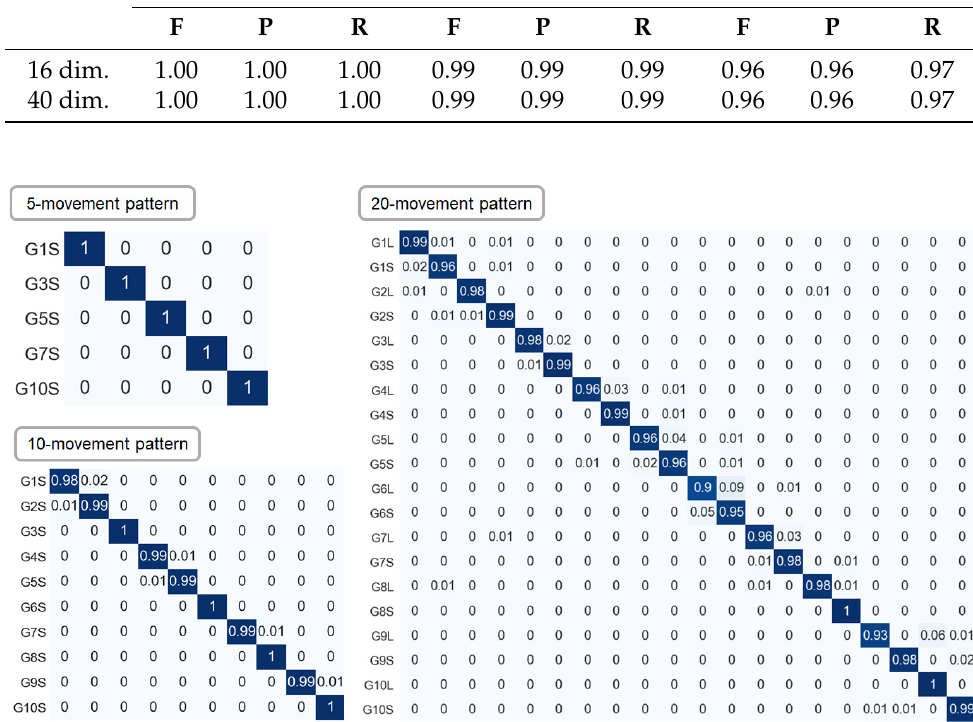
Figure 7. Results of each gaze movement in Evaluation 1. The value is the F-value.